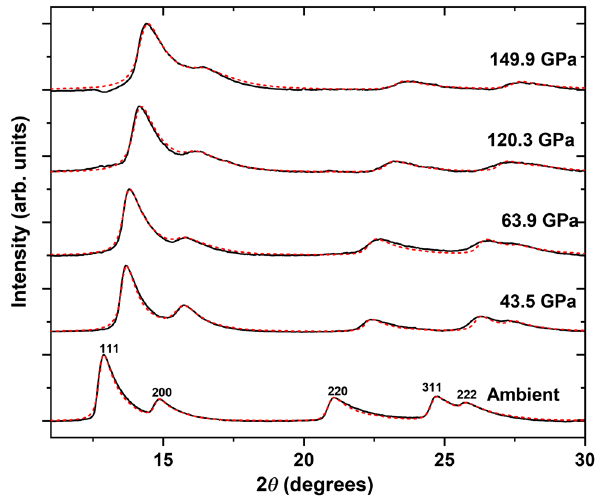
FIG. 2. Shocked gold XRD results. Representative measured and simulated x-ray diffraction line profiles for gold at ambient conditions and for four different shock stresses. Line profiles measured in the shocked states have both the background and the ambient portion of the XRD line profile subtracted. Simulated line profiles (red dashed lines) for shock-compressed Au use lattice parameter ( a ) and stacking-fault probability ( α ) values that give the best match to the measured line profiles. The simulation of the ambient line profile uses the ambient Au lattice constant a ¼ 4 . 0782 Å and α ¼ 0 . The simulated line profiles are con- voluted with a Lorentzian function whose width increases linearly with increasing shock stress (see SM